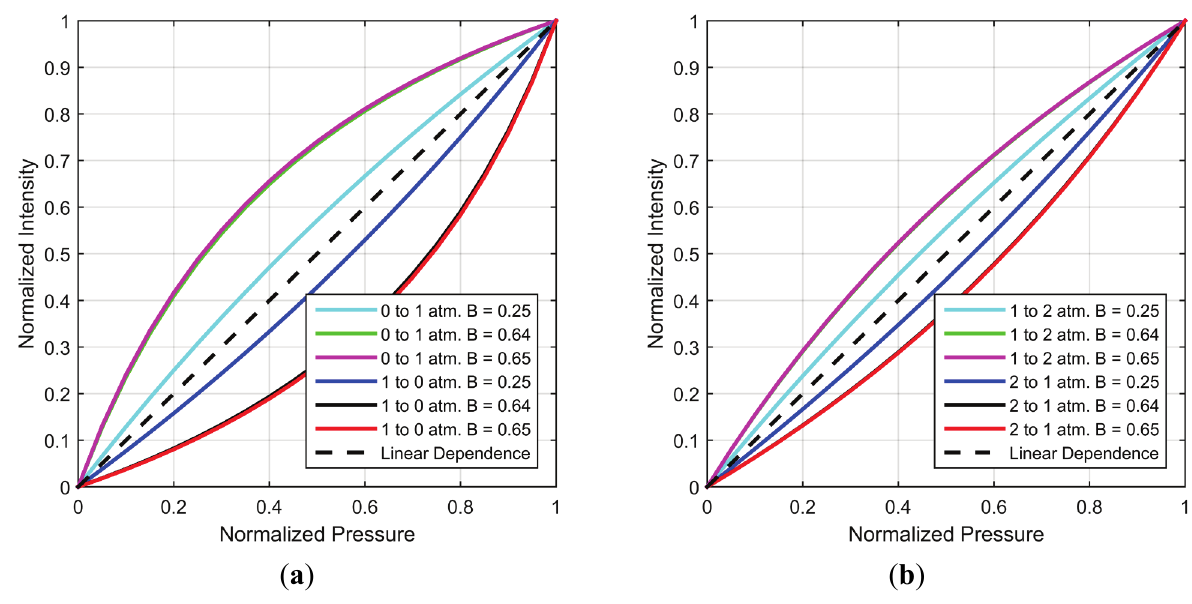
Figure 12. Normalized Intensity vs. Normalized Pressure for a pressure jump between ( a ) 0 and 1 atm. and ( b ) 1 atm. and 2